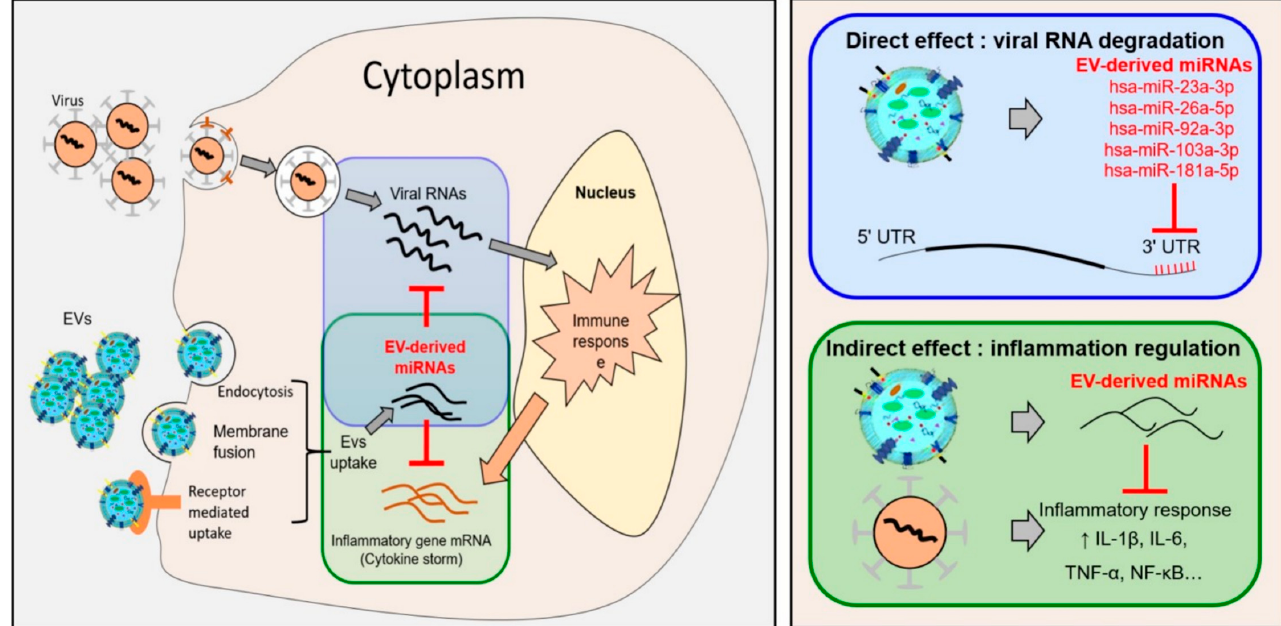
Figure 5. A theoretical mechanism underlying the antiviral effect of MSC-EV-derived miRNAs against SARS-CoV-2. Antiviral effect of EVs against SARS-CoV-2 viral infections causes a variety of cellular reactions, and viruses themselves are known to create an environment that allows for replication and spread. In addition, the virus causes apoptosis, and the completed virus is easily transmitted. In addition, host cells are known to secrete various cytokines and stimulate immune cells by their protective action. Consequently, it is very important to break down viral replication before stimulation of inflammatory cytokines. Our hypothesis of antiviral effects of miRNAs in EVs and EVs against SARS-CoV-2: SARS-CoV-2 viruses invade cells through ACE2 receptors and EVs enter cells through various pathways, including membrane fusion, receptor-mediated uptake, and active endocytosis. The cell secretes cytokines, induces an immune fraction, and stimulates immune cells to fight the viral infection. Too much cytokine leads to a cytokine storm ( left panel). The direct effects of EV miRNAs on SARS-CoV-2 virus regulation are mediated by targeting regions within the SARS-CoV-2 genome, including the 3’ UTR, the 5’ UTR, and coding sequences. In particular, direct binding to the 3’ UTR is predicted to downregulate SARS-CoV-2 RNA. In addition, EVs regenerate damaged tissue and regulate the proinflammatory environment via their miRNAs and protein cargoes, indicating their potential to suppress cytokine storms caused by viral infection ( right panel). “ ↑ ” means up-regulation.